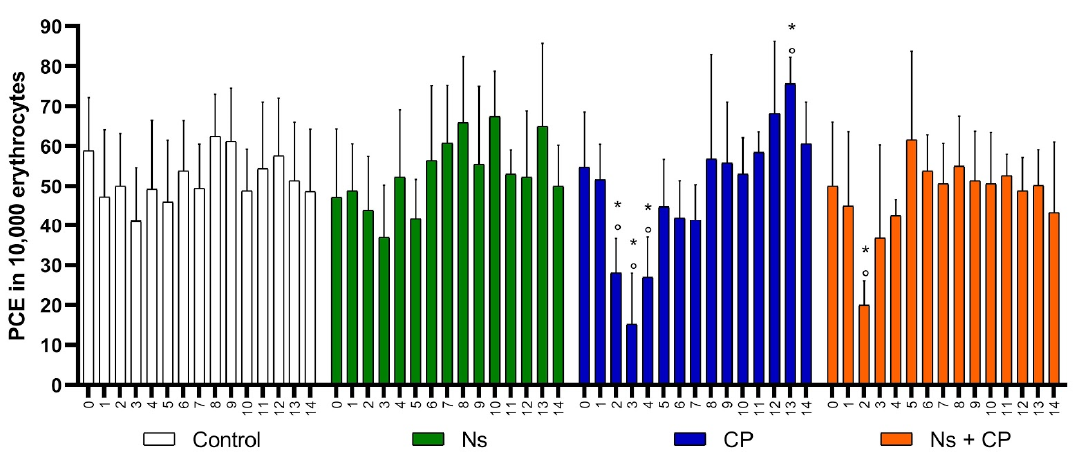
Figure 2. Mean and SD of Polychromatic Erythrocytes in study groups. (PCE—Polychromatic Erythrocytes; Ns— Nigella Sativa (500 mg / kg); CP—Cisplatin (2 mg / kg); X axis: Smears every day; ◦ — p < 0.05 Intragroup comparison; *— p < 0.05 Intergroup comparison).